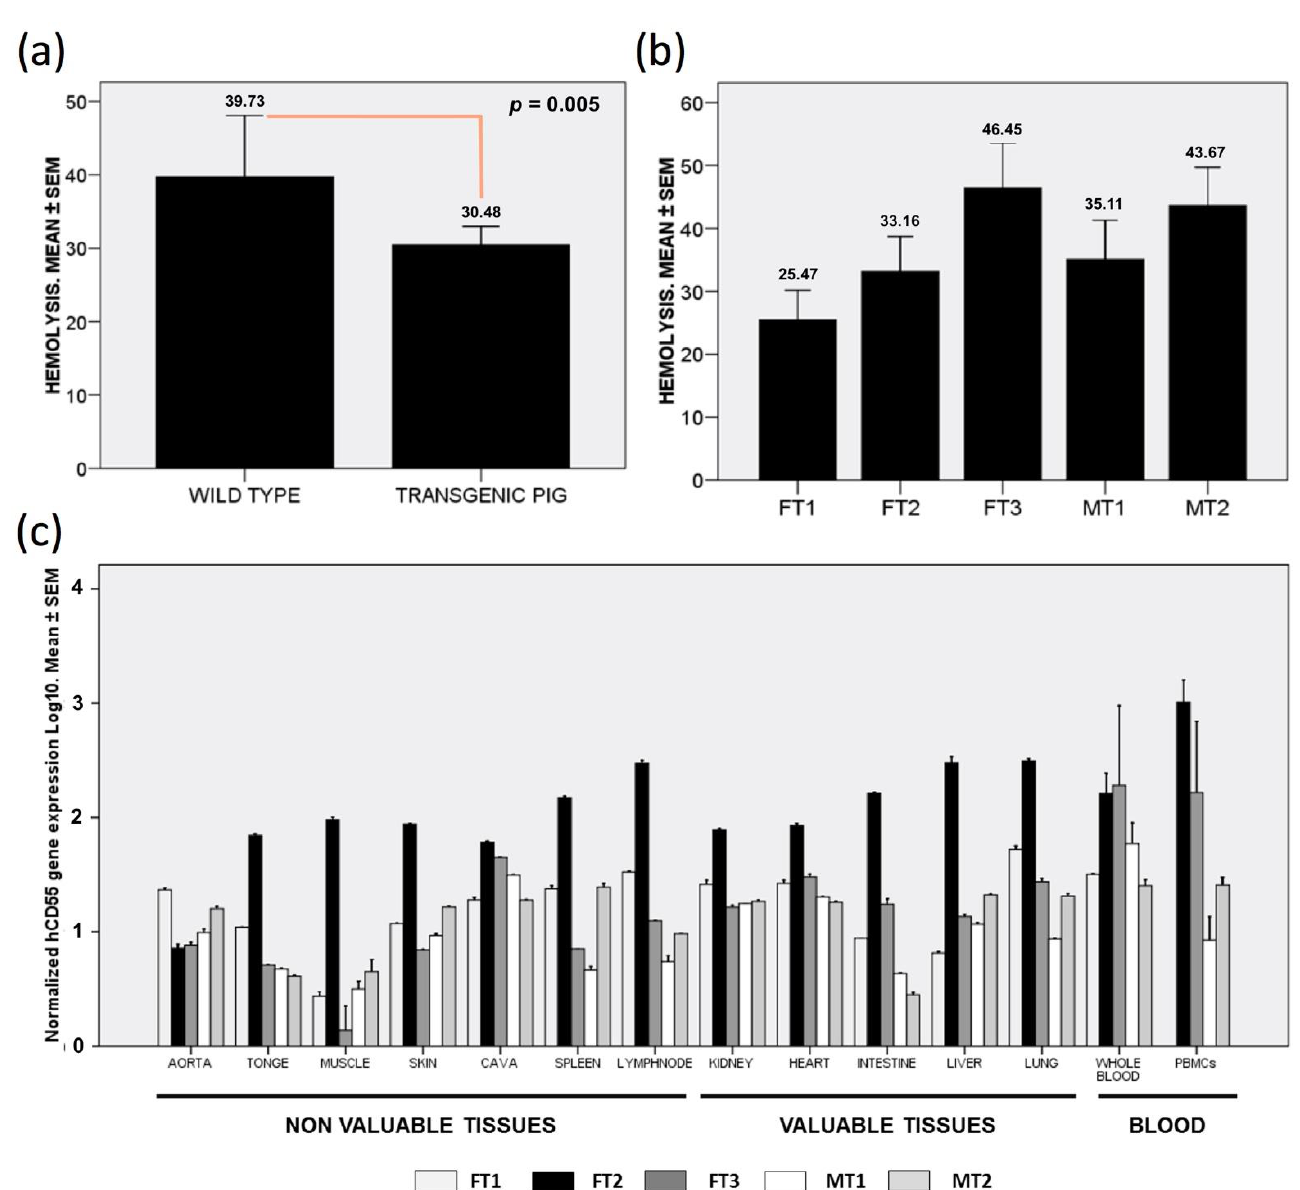
Figure 1. hCD55 transgenic swine experience decreased hemolysis and show mRNA expression in a wide range of tissues. ( A ) Average hemolysis after baboon serum challenge for transgenic and control wild-type swine. ( B ) Hemolysis percentage recorded for individual transgenic specimens challenged with baboon serum. ( C ) Normalized hCD55 mRNA levels in tested tissues from individual transgenic swine, sorted into valuable and not valuable organs for xenotransplantation. Results are shown as mean ± standard error of the mean (SEM) of triplicate measurements.